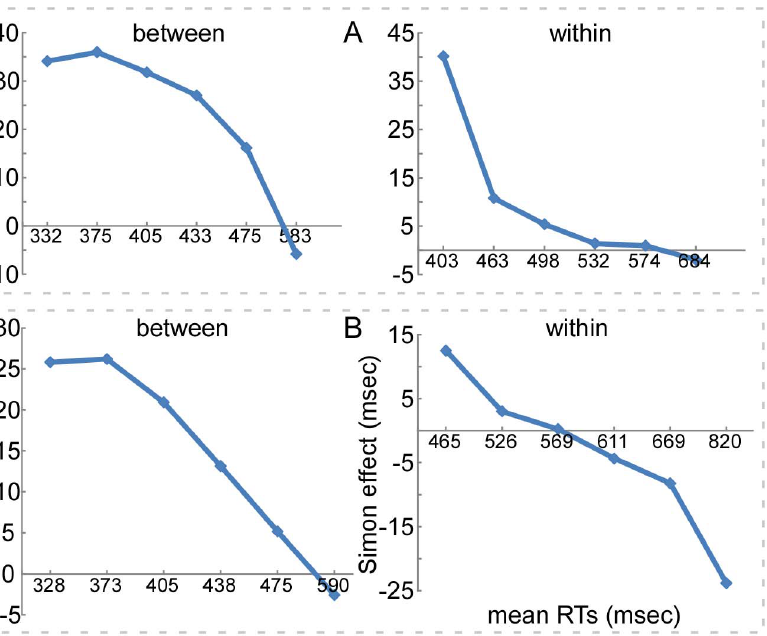
Figure 3. The time course of the Simon effect in Experiment 3. X-axis, mean RTs (msec), divided into six quantiles; y-axis, the Simon effect (msec), calculated by subtracting compatible from incompatible trial type. Panel A illustrates the time course of the Simon effect for Experiment 3A (the between-category color task preceding the within-category color task). It is notable that although the effect typically yields a monotonic decreasing function with increased RTs in both tasks, the slopes are distinctly different in both tasks. Panel B illustrates the time course of the Simon effect for Experiment 3B (with the task order reversed). Left: The Simon effect keeps stable at the first two bins, but almost reduces linearly at the last four bins. Right: The Simon occurs in the first two bins, whereas disappears at the third bin, even reverses by the last three bins.